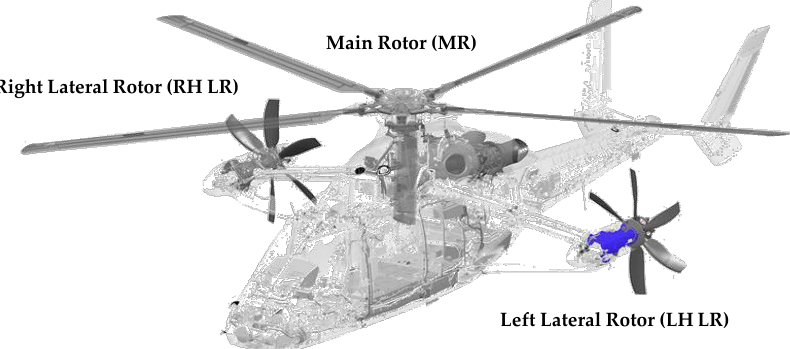
Figure 1. Racer rotorcraft view: details of the vibration sources [33].